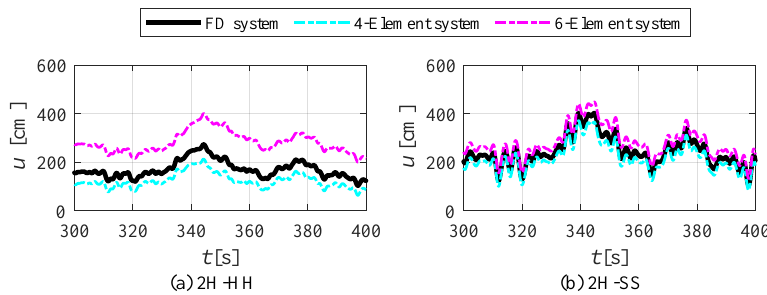
Figure 17. Comparison of the time-history analysis of the along-wind displacement (300–400